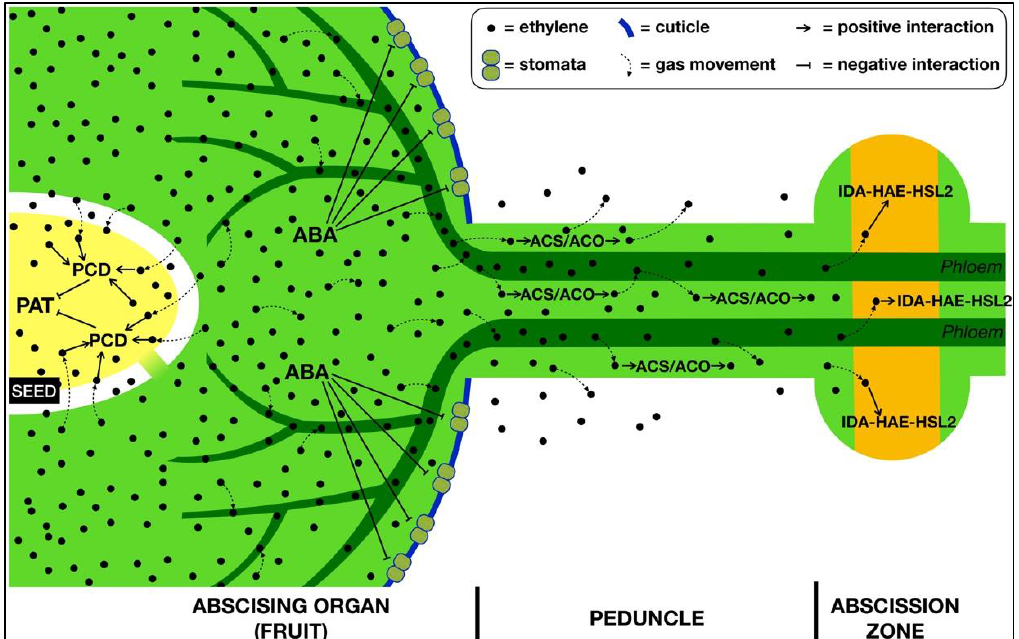
Figure 1. A working model for the involvement of ethylene in the whole process of abscission, taking the fruit as a reference. Upon abscission induction, ethylene and abscisic acid (ABA) are synthetized within the fruit. Ethylene enters the seed / s and block polar auxin transport (PAT) by inducing programmed cell death (PCD) of the embryo / s, so that the reduced auxin stream allows the AZ to become sensitive to ethylene. ABA stimulates stomata closure, thus preventing ethylene from exiting the fruit. The gaseous hormone is thus constricted to diffuse through the liquid phase either apoplastically or symplastically into the vascular system (i.e., the phloem), via the only available way out: the peduncle. Once ethylene reaches the peduncle tissues, it may either diffuse out from it or stimulate its own synthesis through ACS (Aminocyclopropane-1-carboxylic acid synthase or ACC synthase; EC 4.4.1.14) and ACO (Aminocyclopropane-1-carboxylicacidoxidaseorACCoxidase; EC1.4.3.3)enzymes,sothatitprogressively spreads up, finally reaching the AZ with a sufficient amount able to activate the ethylene-sensitive targets, such as the IDA-HAE-HSL2 pathway. Symbols are explained in the